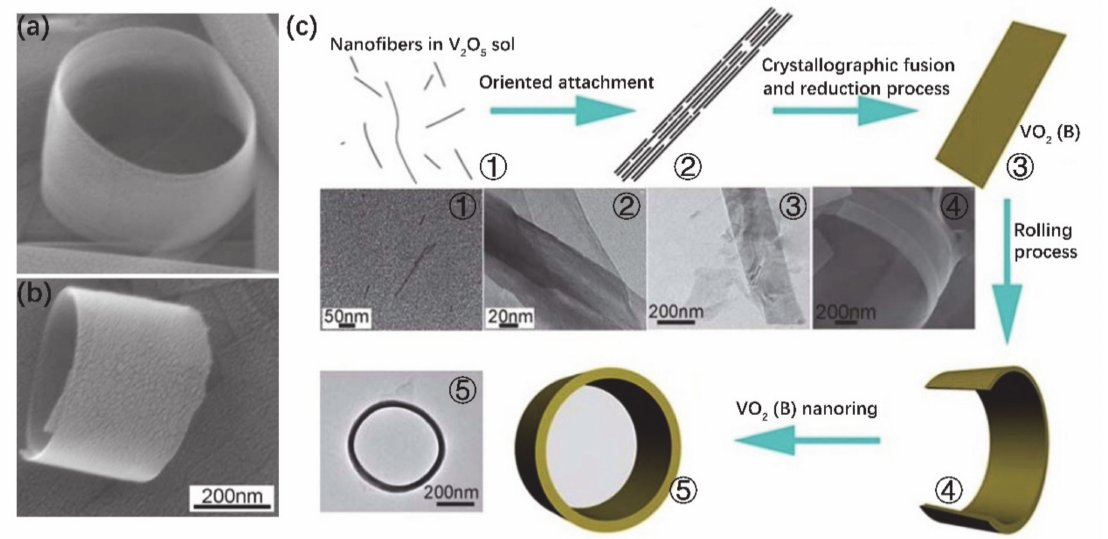
Figure 6. ( a , b ) SEM images of a single VO 2 (B) nanoring viewed from different directions. ( c ) Schematic diagrams of the formation processes of VO 2 (B) nanorings. Reproduced from [64], with permission from Royal Society of Chemistry,